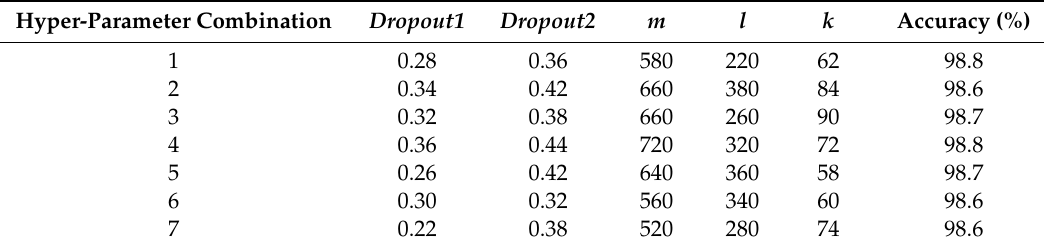
Table 4. The optimized hyper-parameters in the harmony